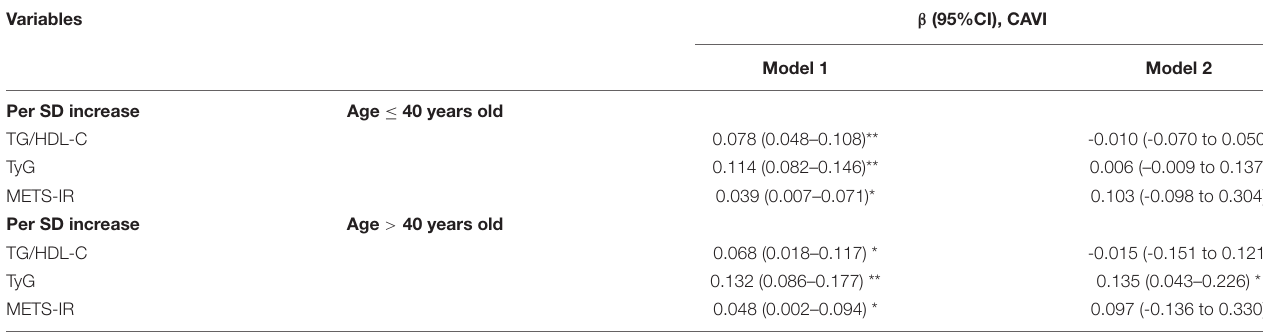
TABLE 4 | Linear regression analyses for the association between non-insulin-based IR indices and CAVI in age subgroup.